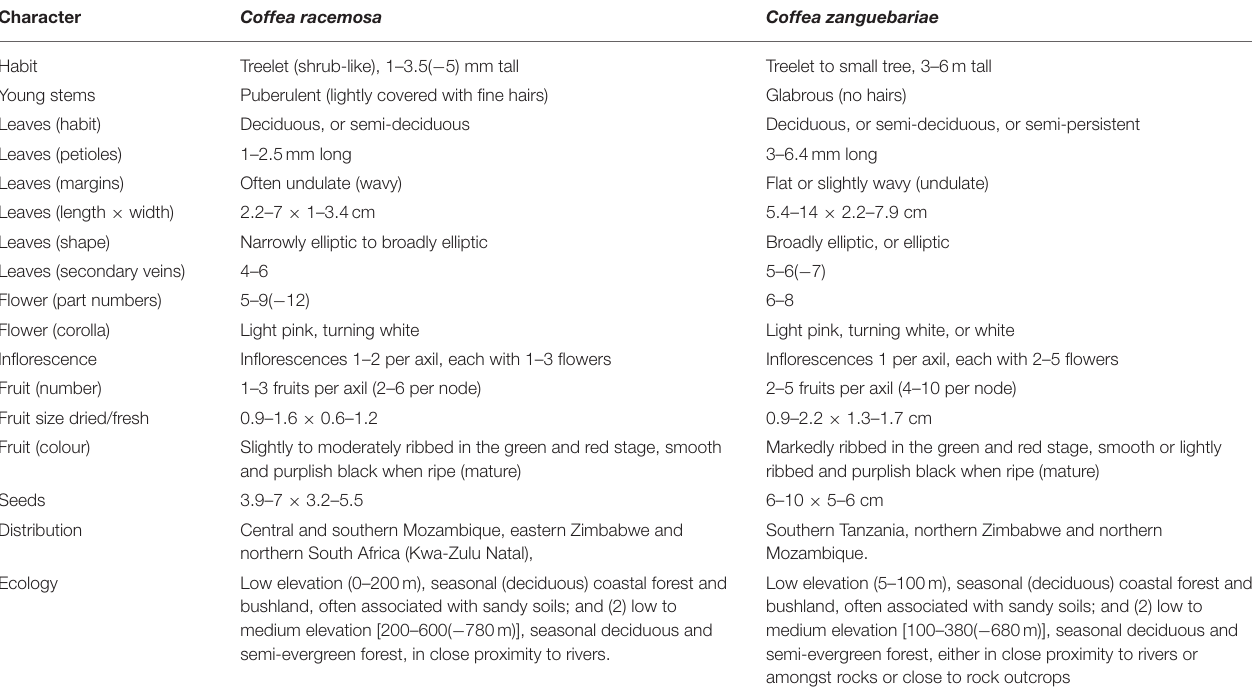
TABLE 2 | Distinguishing morphological characteristics, and distribution and ecology summary for C. racemosa and C. zanguebariae . Character